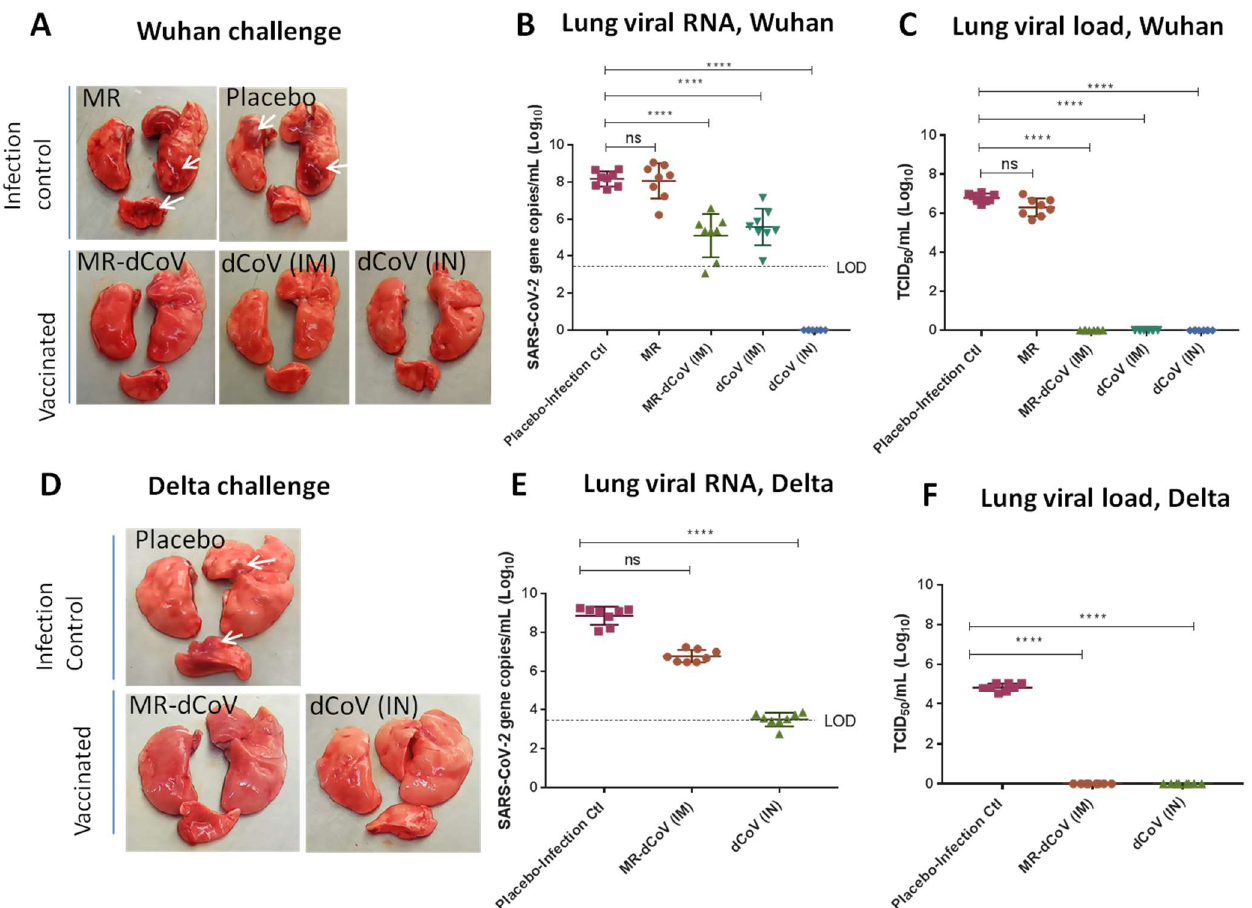
Figure 4. Protection in hamsters post-challenge with wild-type SARS-CoV-2 variants: ( A – C ) Chal- lenge with Wuhan strain, ( A ) gross pathology of lungs from vaccinated (MR-dCoV or control dCoV) and unvaccinated (placebo). Multifocal hemorrhages (white arrows) are evident in the lungs from unvaccinated control groups. ( B ) Viral RNA detected via qRT-PCR. ( C ) Live virus detected via TCID 50 assay. ( B , C ) Placebo-infection control (square), MR (circle), MR-dCoV (triangle), and dCoV administered via IM route (inverted triangle) and via IN route (diamond). ( D – F ) Challenge with Wuhan strain, ( D ) multifocal hemorrhages (white arrows) are evident in the lungs from unvaccinated control groups. ( E ) Viral load detected in the lungs on day 94. ( F ) Live virus detected in lungs via TCID 50 assay. ( E , F ) Placebo-infection control (square), MR-dCoV (circle) and dCoV (triangle). Error bars = mean ± SD, n = 8, one-way ANOVA—Dunnett’s multiple comparison test, **** = p ≤ 0.0001, ns = no significant difference observed with respect to infection control groups.